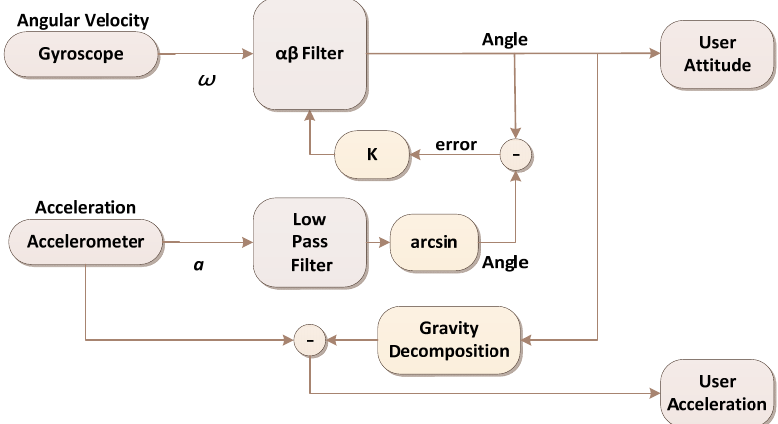
Figure 4. The flowchart of the gait recognition